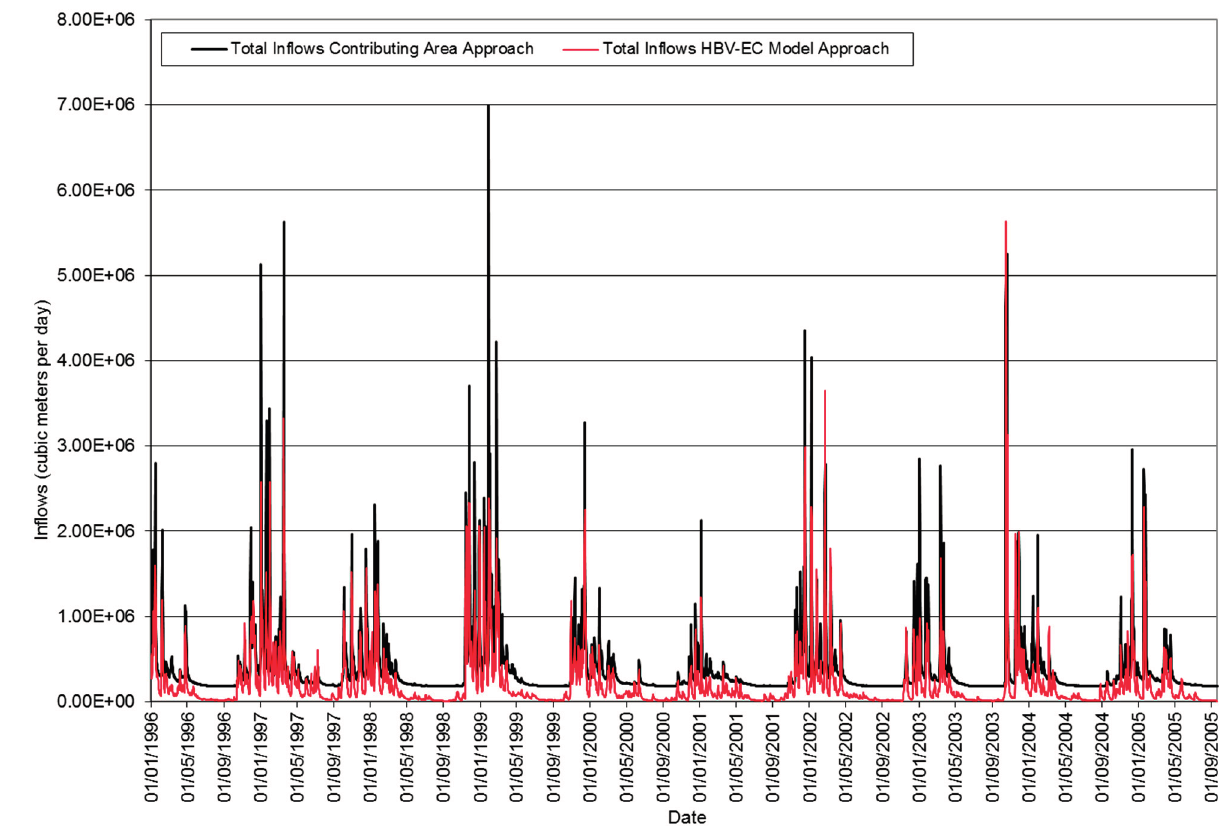
Figure 2. A Comparison of inflow estimates from the HBV model and the Contributing Area Approach (m 3 ·d − 1